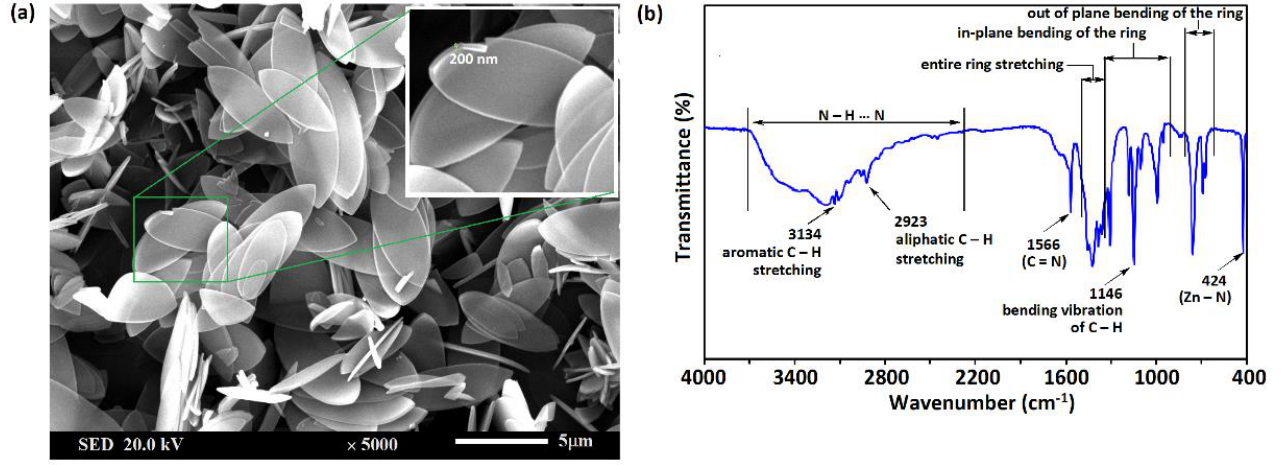
Figure 1. The structural morphology of ZIF-L: ( a ) SEM image and ( b ) FTIR spectrum of synthe- sized